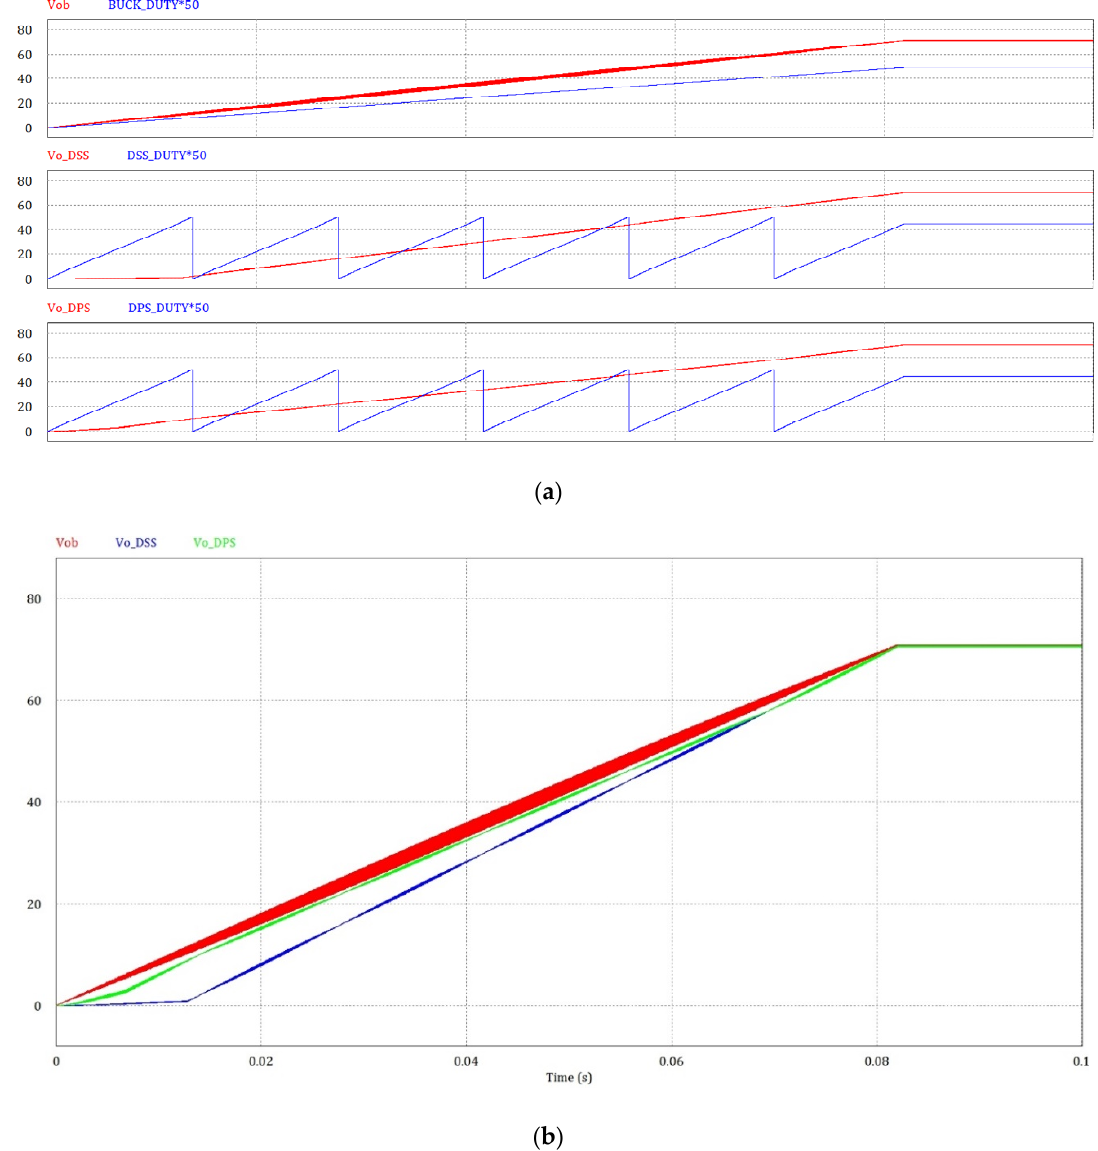
Figure 13. Comparison between the output voltages of the existing converter and proposed converter: ( a ) output voltage waveforms of three converters ( b ) differences between the output voltages of three converters.